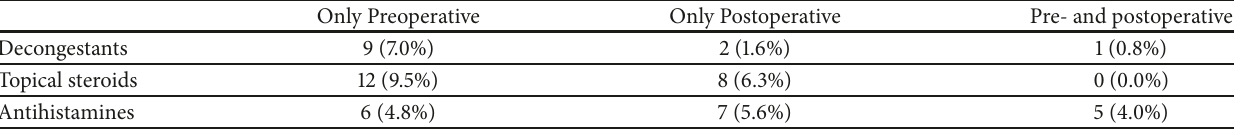
Table 4: Number of patients using nasal medication daily at either the pre- or postoperative assessments or at